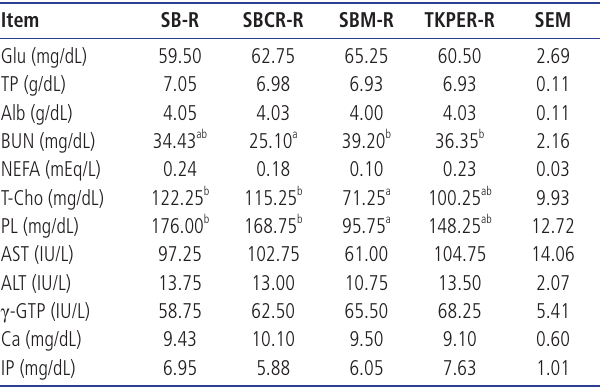
Table 5. Blood metabolites in wethers fed with the experimental